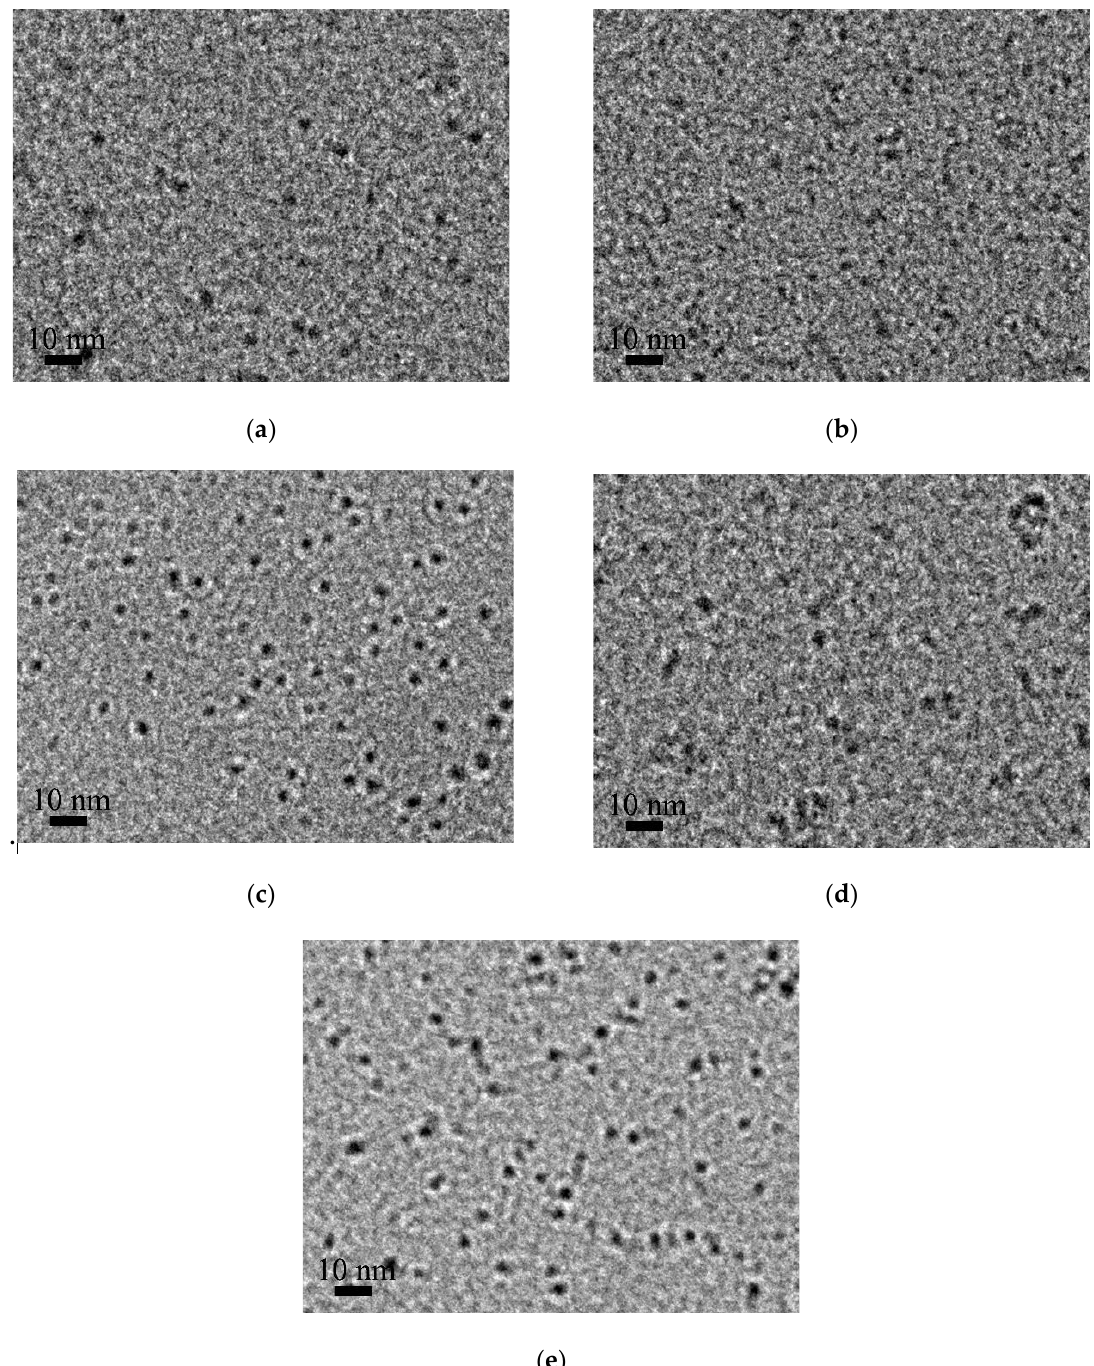
Figure 1. The morphology of iron colloidal particles prepared at different temperatures: ( a ) 40 °C; ( b ) 50 °C; ( c ) 60 °C; ( d ) 70 °C; ( e ) 80 °C.